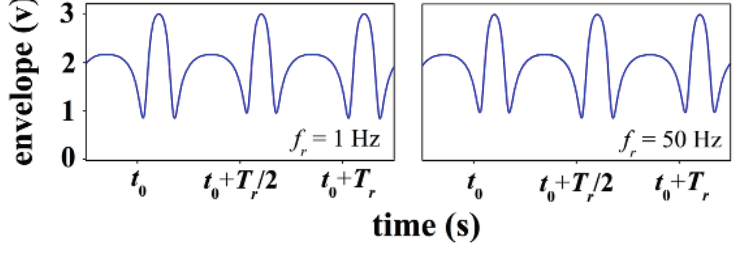
Figure 23. Angular velocity measurements for an arbitrary initial time t 0 . From [47]; reprinted with permission from IEEE